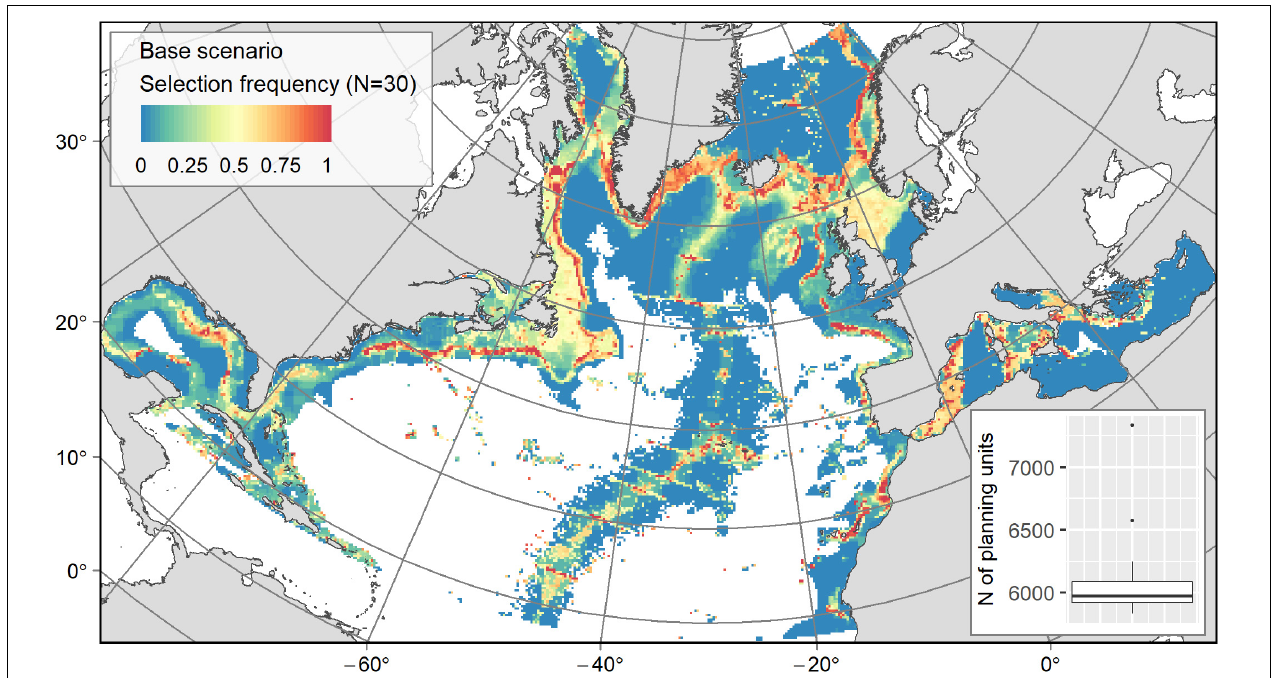
FIGURE 4 | Output from the “Base” scenario: map of PU selection frequency from the 30 solutions with a boxplot showing the number of PUs in the